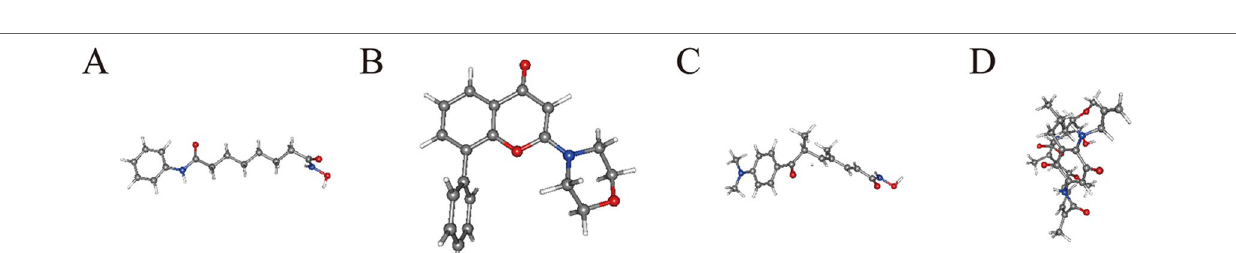
FIgUrE 5 | Protein–protein interaction (PPI) network analysis. (A) Using the STRING online database, a total of 161 DEGs were filtered into the DEGs PPI network. (B) Degree of the top 30 nodes in the PPI